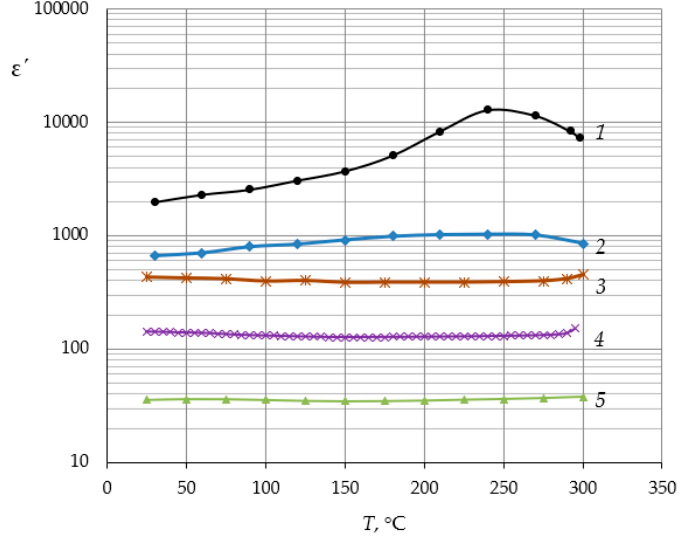
Figure 7. Comparison of temperature dependences of dielectric permittivity for a bulk ceramic sample PZTNB-1 (1); film sample PZTNB-1 on a Si-Pt substrate ( 2 ); film samples of a composite of nanosized PZTNB-1 powder in polymer PBO ( 3 , 4 ) and PBO-F ( 5 ) matrices. The ratio of the PZTNB-1 filler was around 45 ( 3 ), 35 ( 4 ), and 30 ( 5 ) vol. %.